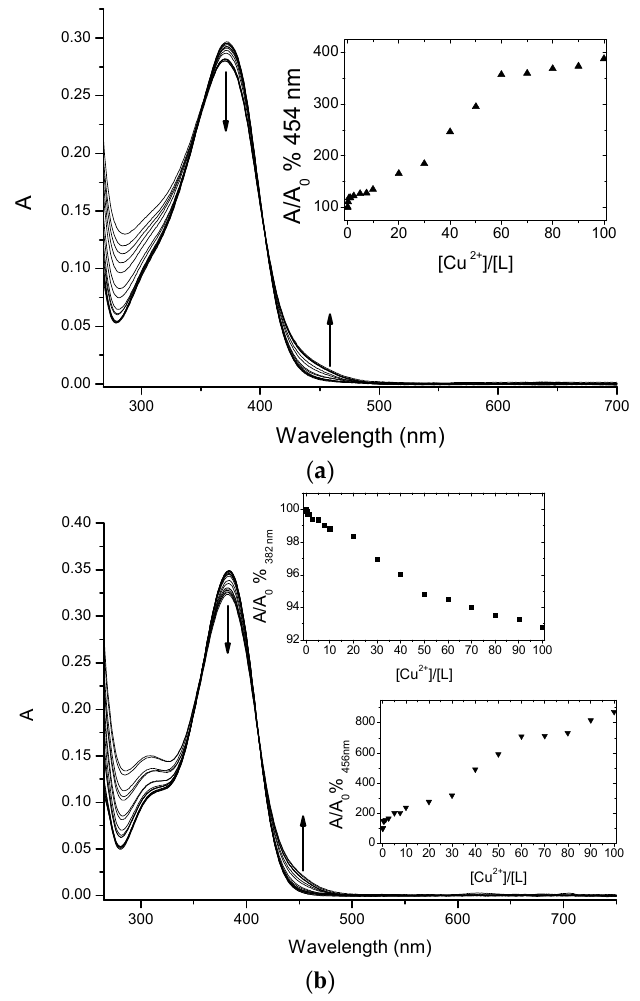
Figure 3. Titration curves of 4 ( a ) and 5 ( b ) (at 5 µM concentration) with increasing amounts of Cu(II) in MOPS 10 mM pH 7.4/DMF (1:4). Inset: absorbance ratio at 382 nm versus Cu(II) equivalents.